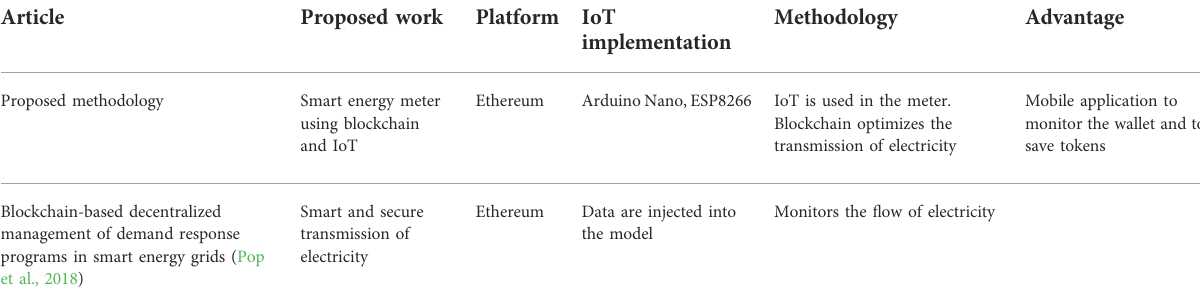
TABLE 3 Comparison of the proposed work with a state-of-the-art